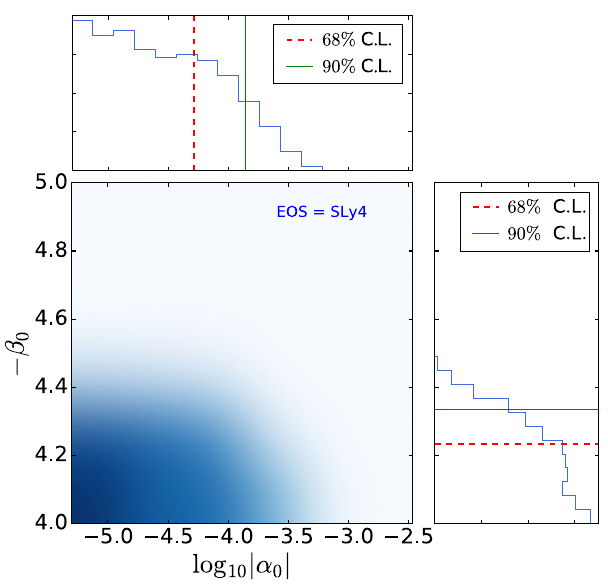
FIG. 3. The marginalized 2D distribution of ð log 10 j α 0 j ; − β 0 Þ from MCMC runs on the five pulsars listed in Table I, for the EOS SLy4 . The marginalized 1D distributions and the extraction of upper limits are illustrated in the upper and right